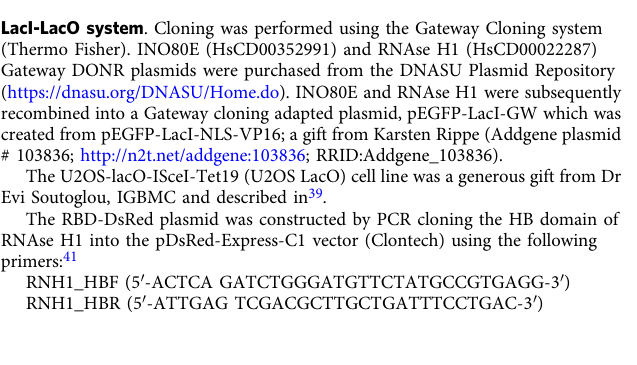
DNA fi bre labelling . DNA fi bre analyses were performed following standard protocol 63 with slight modi fi cations. Brie fl y, exponentially growing PC3 cells were fi rst incubated with 25 µM chlorodeoxyuridine (CldU) and then with 250 µM iododeoxyuridine (IdU) for the indicated times. Spreads were prepared from 2500